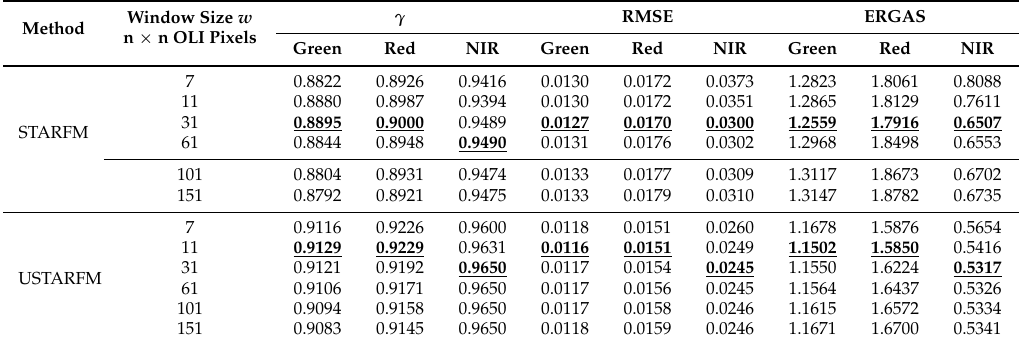
Table 3. The accuracy of the STARFM and USTARFM at different window size scales.